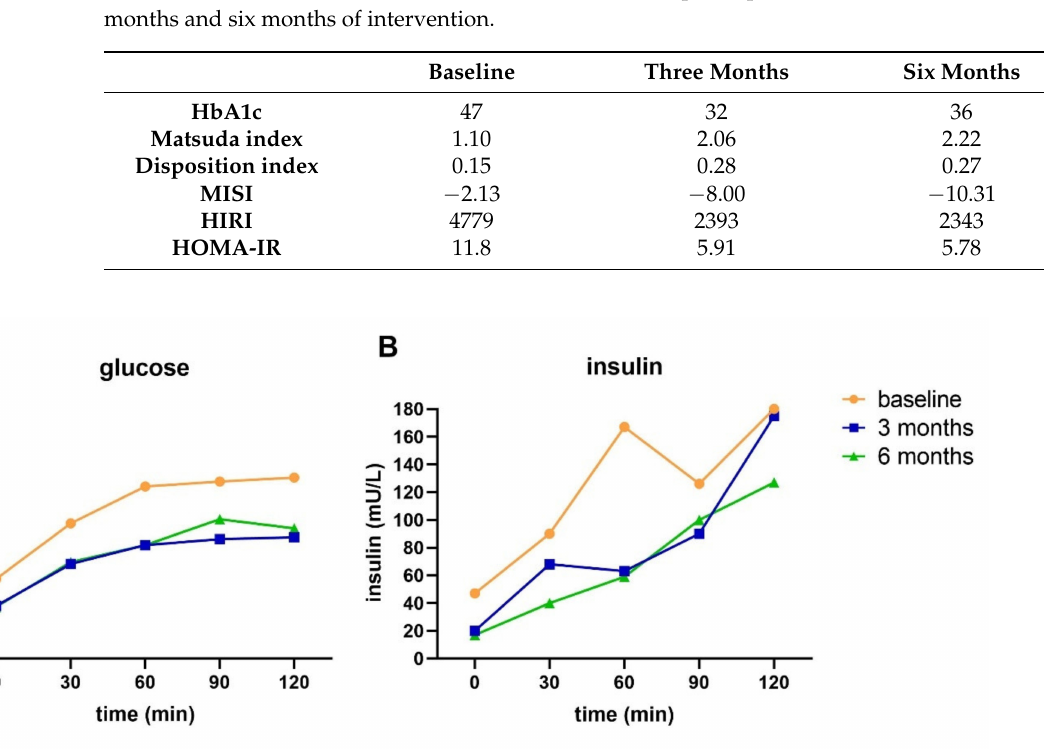
Figure 3. Glucose ( A ) and insulin ( B ) response to an OGTT at baseline and after three and six months of intervention for participant